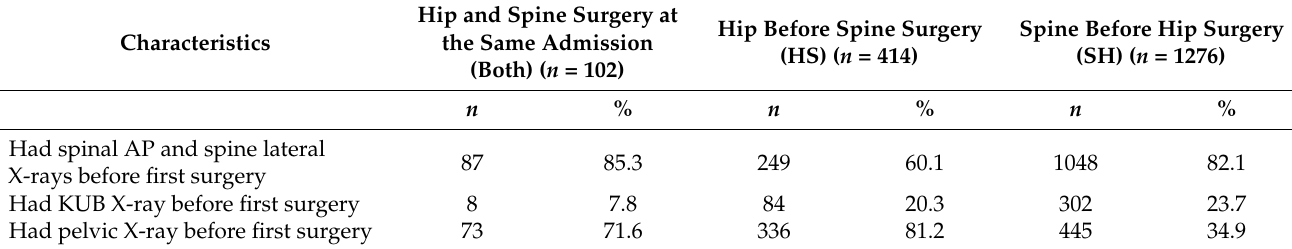
Characteristics